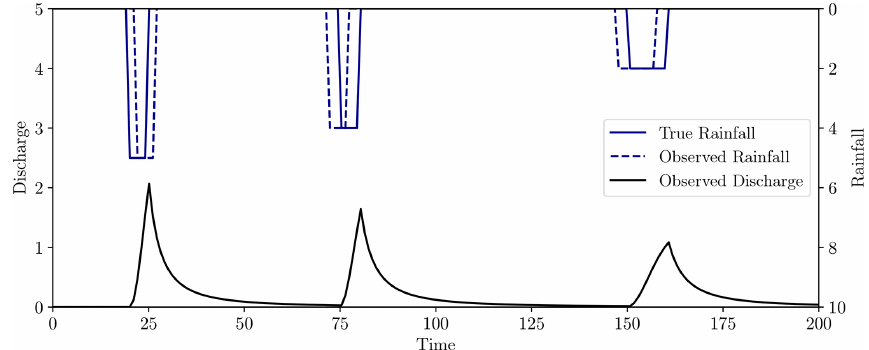
Figure 10. True rainfall (solid blue) with timing errors in observations (dashed blue) and the observed hydrograph (black) produced from the true rainfall and storage model described by Eqs. (21) and (22) with model parameters (10, 2, 0.7).